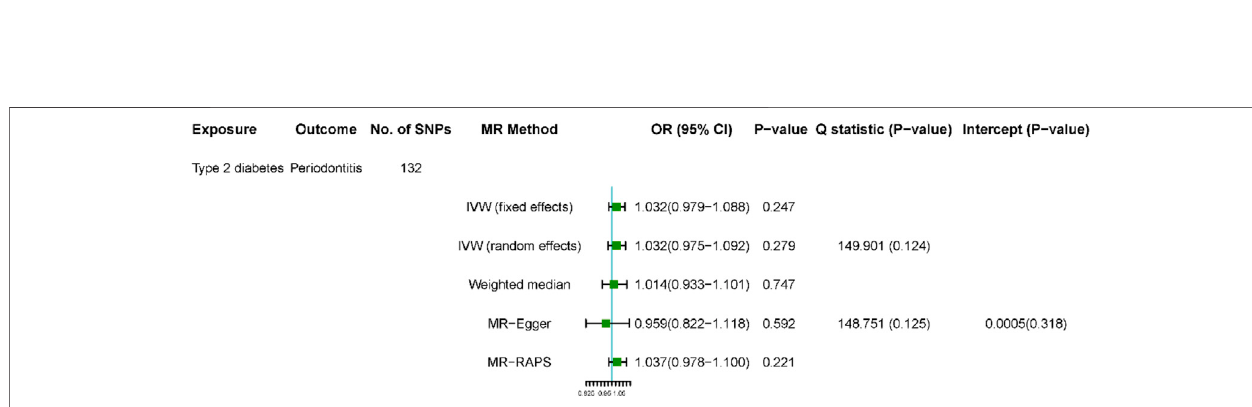
Frontiers in Genetics |